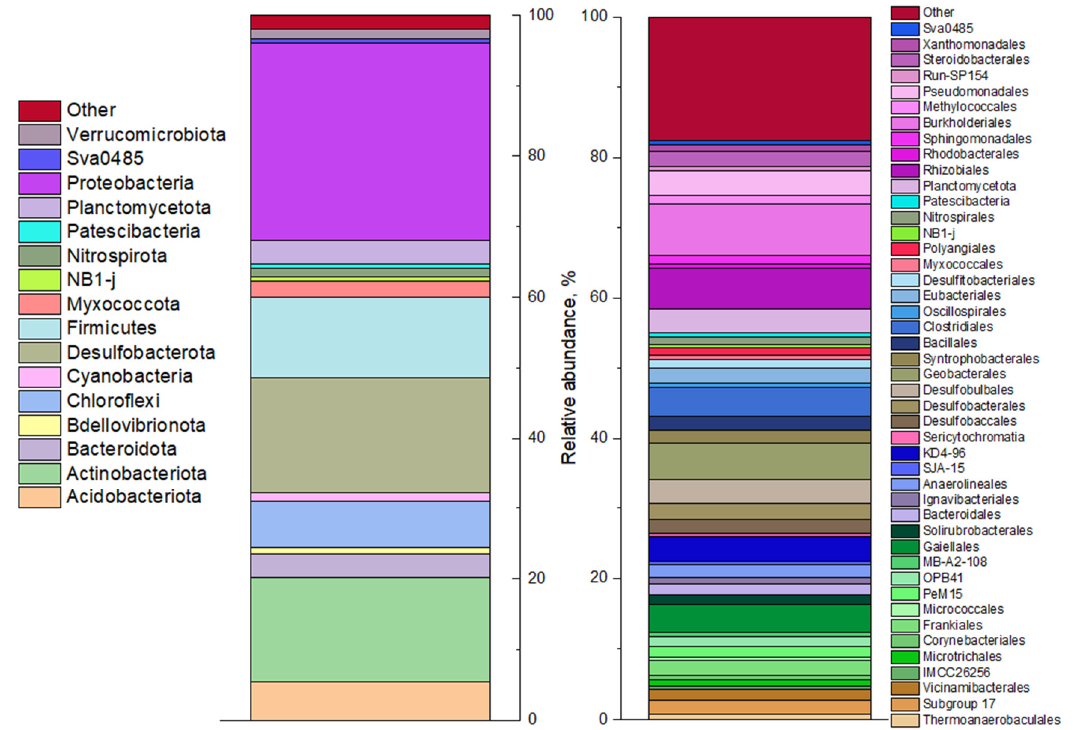
Figure 3. Profiling the microbial community of an anaerobic sludge sample by 16S rRNA genes (phylum level shown on the left and familia level on the right).